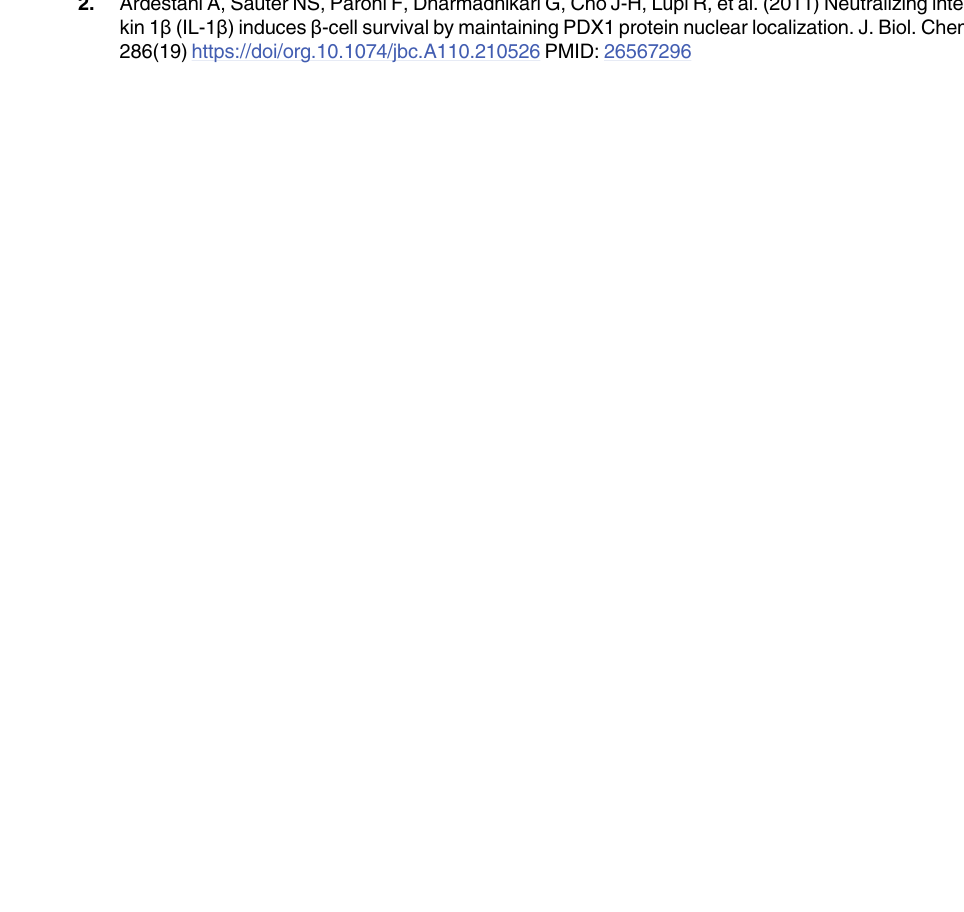
S5 File. Updated Supplementary Figure 2. S6 File. Updated Supplementary Figure